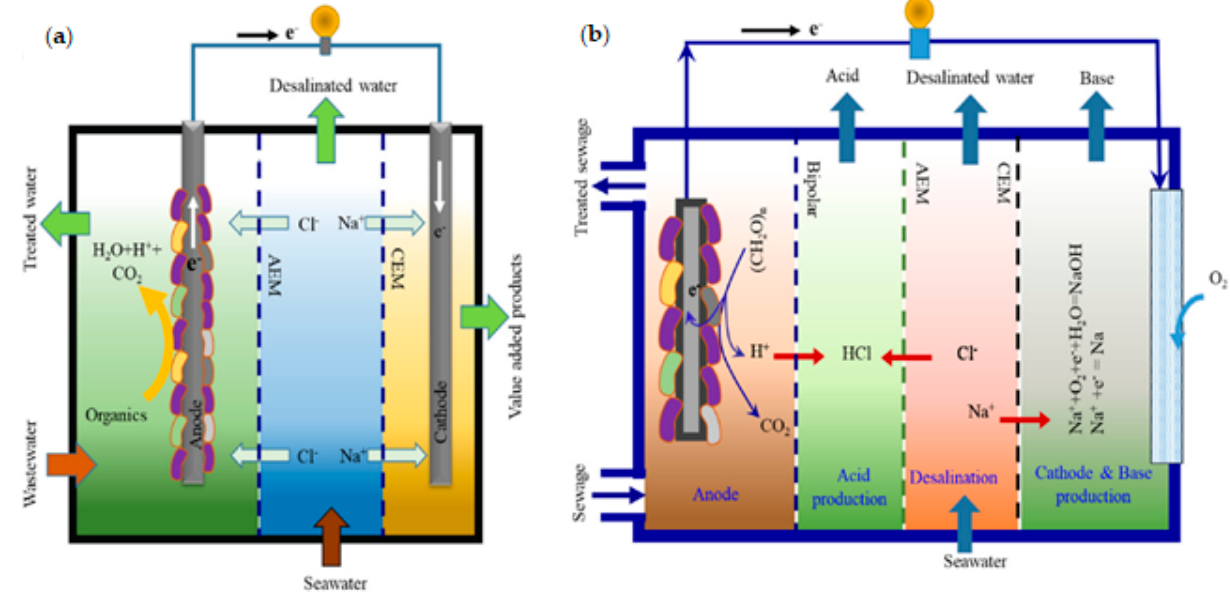
Figure 1. In ( a ), a three-chambers MDCs for salty water desalination is sketched. In ( b ), the layout of more recent MDCs with four-chambers, able to realize the synthesis of HCl in addition to desalination, is displayed. In all MDCs, ion-exchanging membranes realize the separation between compartments. AEM: anionic-exchanging membrane; CEM: cationic-exchanging membrane (with permission of Rahman et al., 2021) [22].